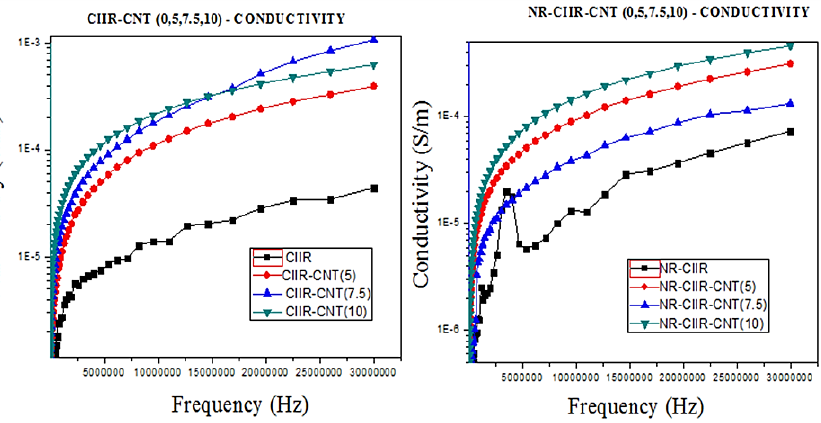
Figure 11. Frequency dependencies of AC conductivity of CIIR and CIIR-NR-CNT rubber nanocomposite with different filler concentrations.